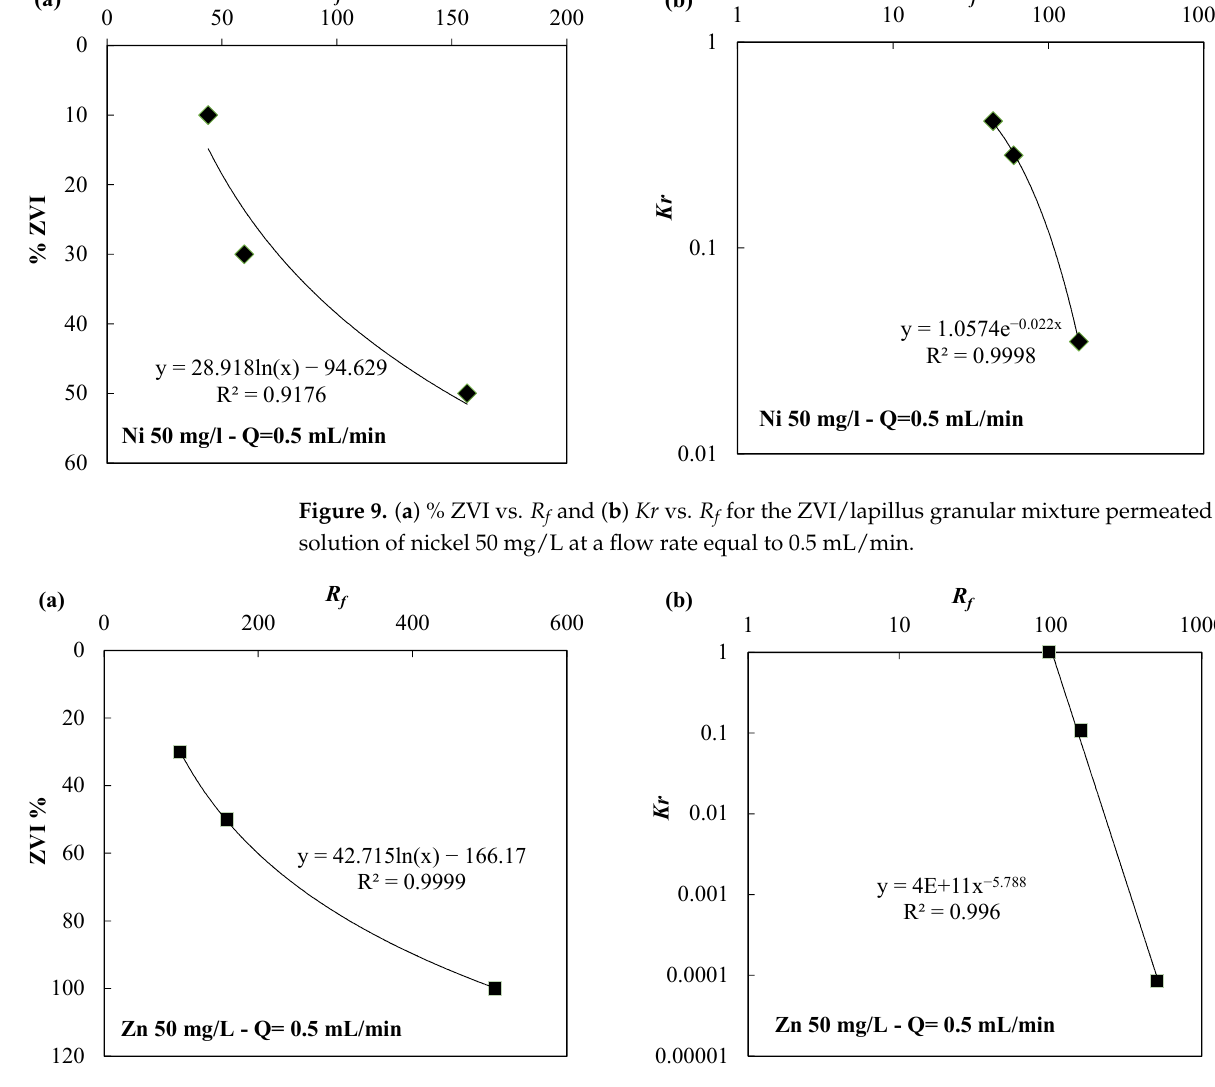
Figure 10. ( a ) ZVI % vs. R f and ( b ) Kr vs. R f for the ZVI/lapillus granular mixture permeated with a solution of zinc 50 mg/L at a flow rate equal to 0.5 mL/min.